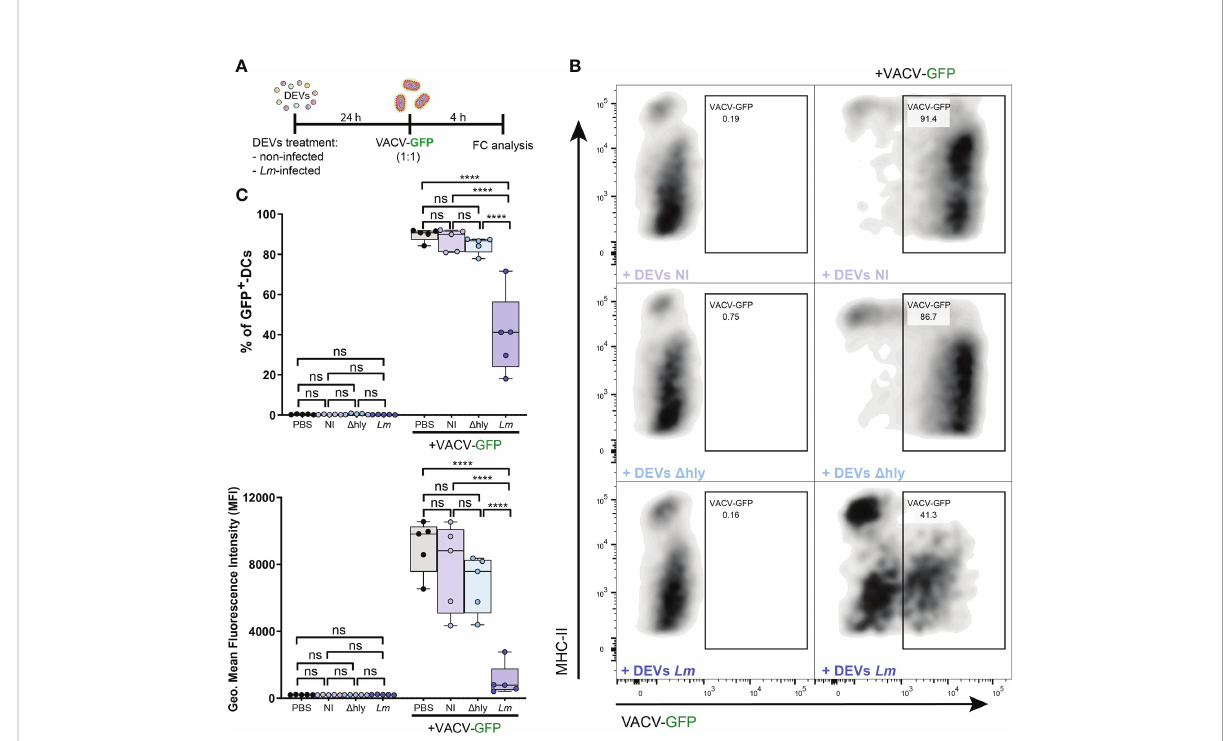
FIGURE 6 DEVs isolated from Lm -infected BMDCs protect against subsequent viral infections. (A) BMDCs were treated with PBS or DEVs from non- infected, D hly-Lm or Lm -infected BMDCs. After 24h, treated BMDCs were infected or not with recombinant VACV-GFP for 4 hours in 1:1 ratio. The level of infection was measured by fl ow cytometry as GFP + infected cells. (B) Dot plots shows the gating strategy used to detect the level of BMDCs infection. (C) Statistical analysis of BMDCs infected with recombinant VACV-GFP. BMDC population was gated on alive CD11c + MHCII + cells. ( n= 5, one-way ANOVA test with Tukey ’ s posttest; **** P < 0.0001 and ns, not signi fi